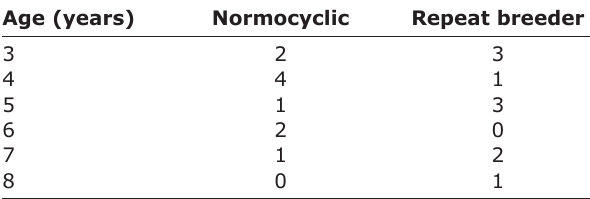
Table-1: Age of normocyclic and repeat breeder cows.